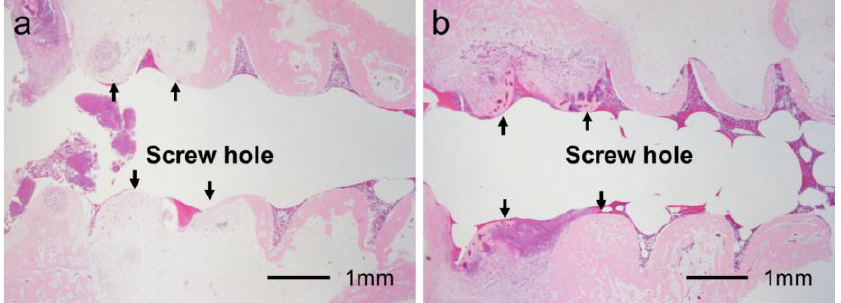
Figure 8. Histological section showing partial osteomyelitis (Grade 1b). ( a ) UN group: No or very little bone was formed in medullary cavity regions (arrows); ( b ) Ap group: Dense bone was formed in the cortical and medullary cavity regions (arrows) even in the presence of partial osteomyelitis.